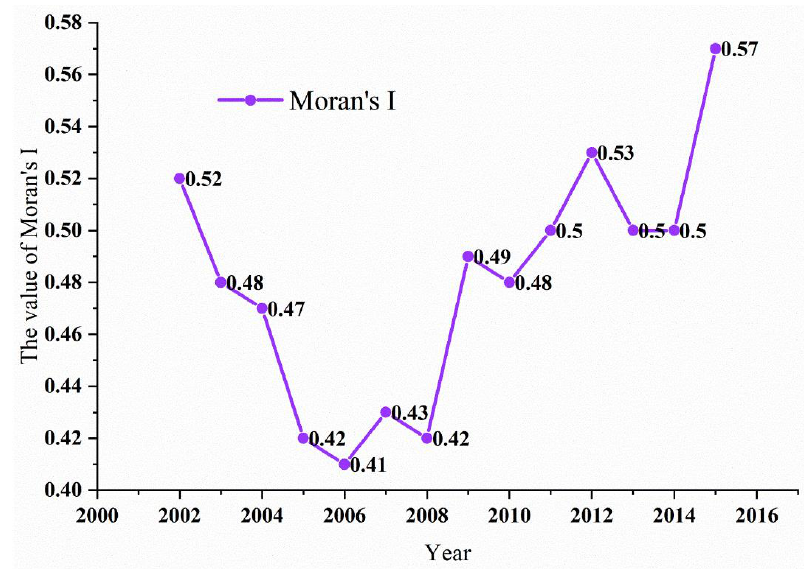
Figure 7. Global Moran ’ s I of the EEoSLCP, 2000 to